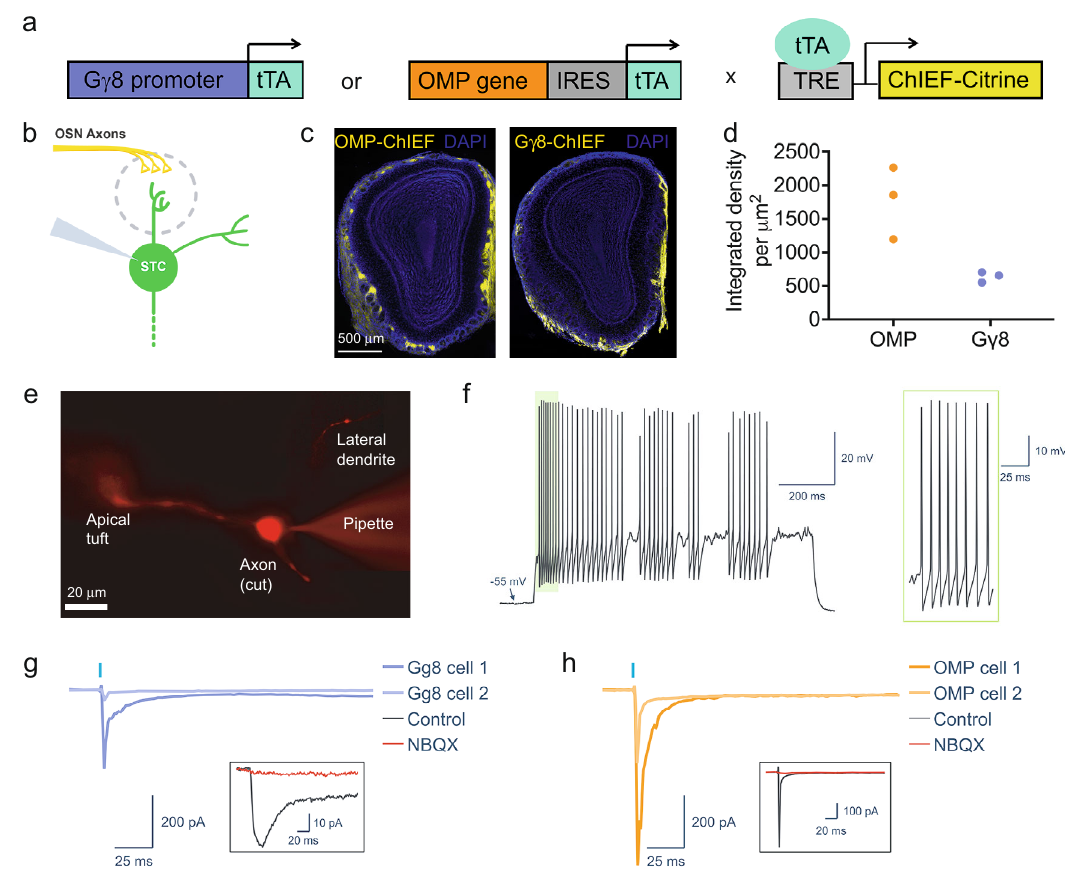
Fig.7|IsolatingmonosynapticOSNinputtosuper fi cialtuftedcells.a Schematic of breeding strategy to generate mice expressing ChIEF-Citrine in either immature ormatureOSNsundercontroloftheG γ 8orOMPpromoter,respectively,usingthe tetracyclinetransactivatorsystem. b SchematicofrelevantOBglomerularcircuitry. Whole cell voltage-clamp recordings were made from STCs in either G γ 8-ChIEF- CitrineorOMP-ChIEF-Citrinemice. c Wide fi eld fl uorescenceimagesshowingChIEF- Citrine-expressing axons in an OMP-ChIEF-Citrine and a G γ 8-ChIEF-Citrine mouse. d Integrated density of Citrine fl uorescence per μ m 2 of the glomerular layer in OMP-ChIEF-Citrine and G γ 8-ChIEF-Citrine mice ( n =3 per group). Symbols: values for individual mice. e Wide fi eld fl uorescence image of an STC fi lled with AF594, showinganapicaldendrite,alateraldendrite,andacutaxon.Apicaldendriteswere